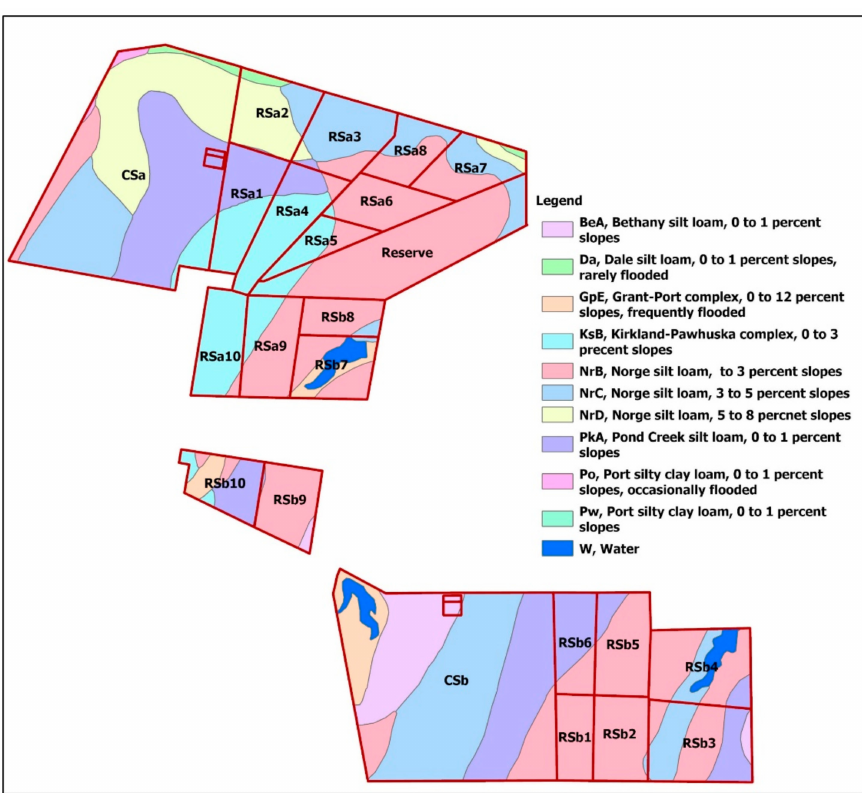
Figure 2. Map of research site at the USDA-ARS Grazinglands Research Laboratory, showing continuous (CSa, CSb) and rotational (RSa, RSb) locations on the USDA Natural Resources Conservation Service soils map. White boxes indicate exclosures for embedded high-density, short-duration grazing treatments described in Appendix